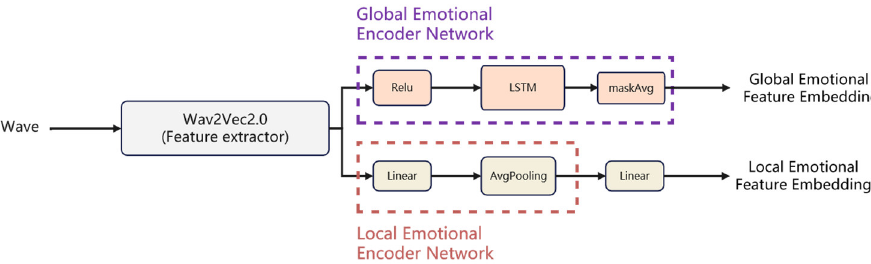
Figure 5. Emotional encoder network.